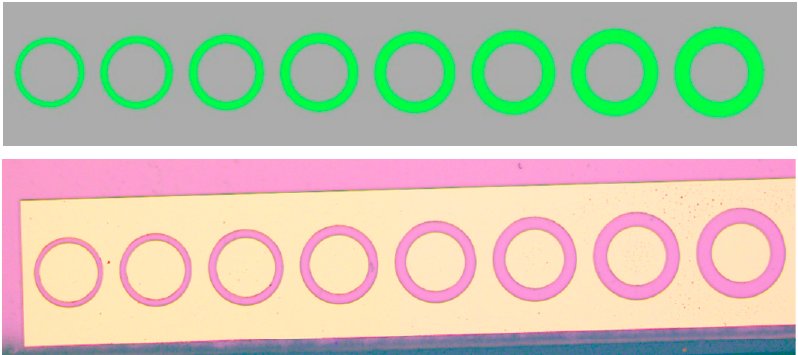
Figure 2. Schematic and optical image of the circular transmission line measurements (c-TLM) patterns used for the contact resistance measurements.